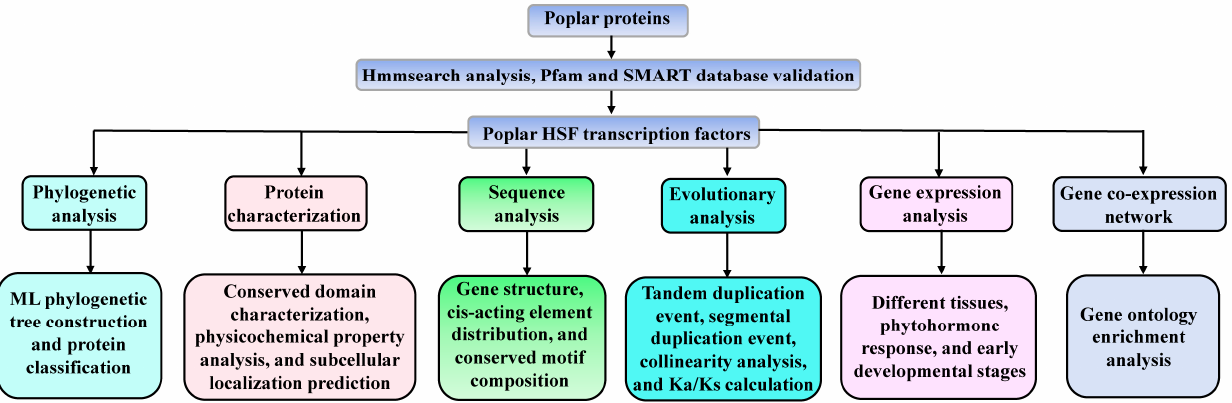
Figure 1. Framework diagram for the analysis of this